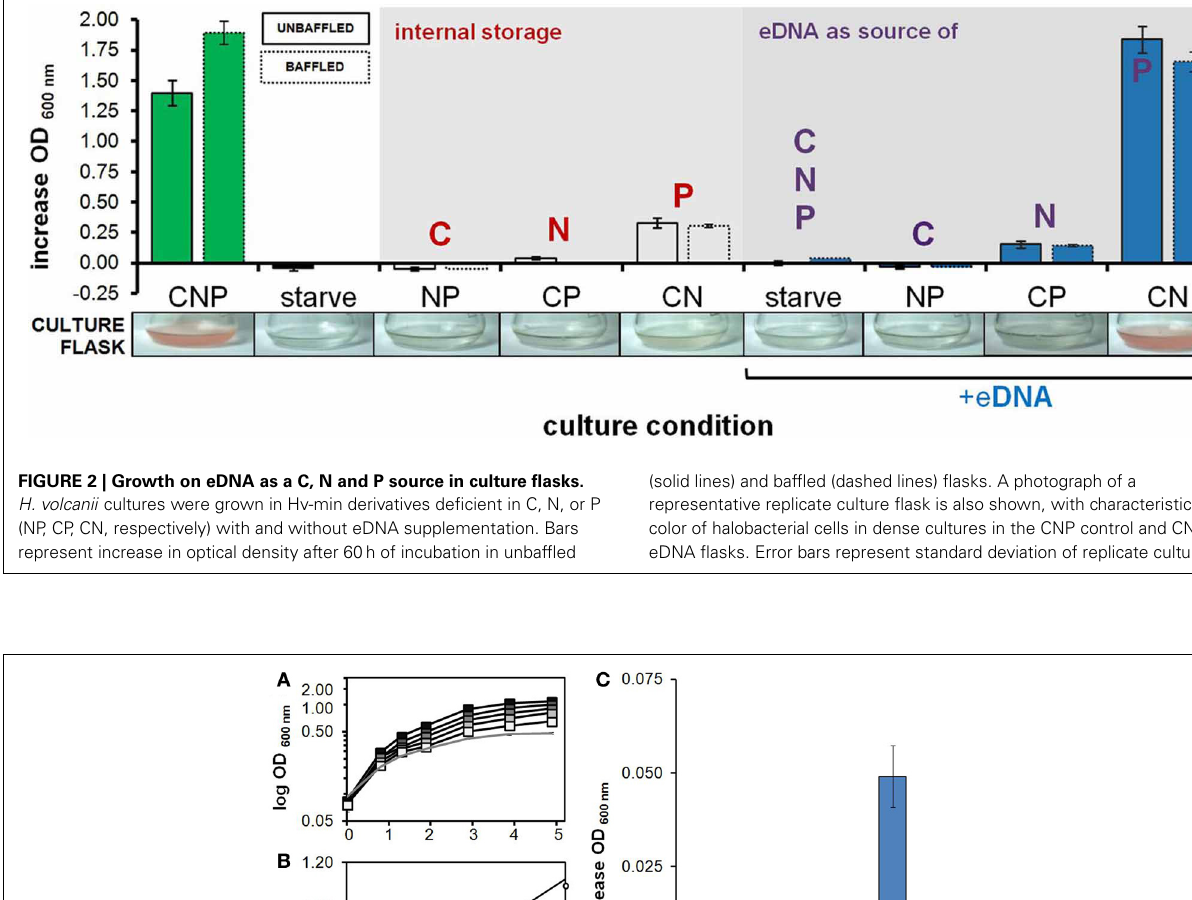
FIGURE 3 | Characterization of growth on eDNA as a phosphorus source. (A) Growth on eDNA as a P source is concentration dependent. H. volcanii DS2 cultures in minimal medium lacking a phosphorus source were provided with unmethylated E. coli DNA at final concentrations of 50, 100, 150, 200, and 250 μ g/ml (gray squares, increasing darkness). (B) Optical density achieved after 5 days of incubation at increasing DNA concentrations. (C)